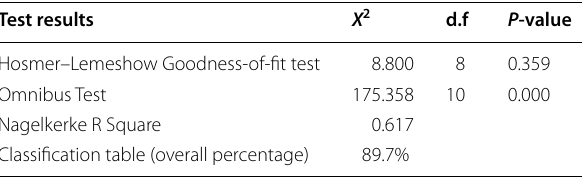
Classification table (overall